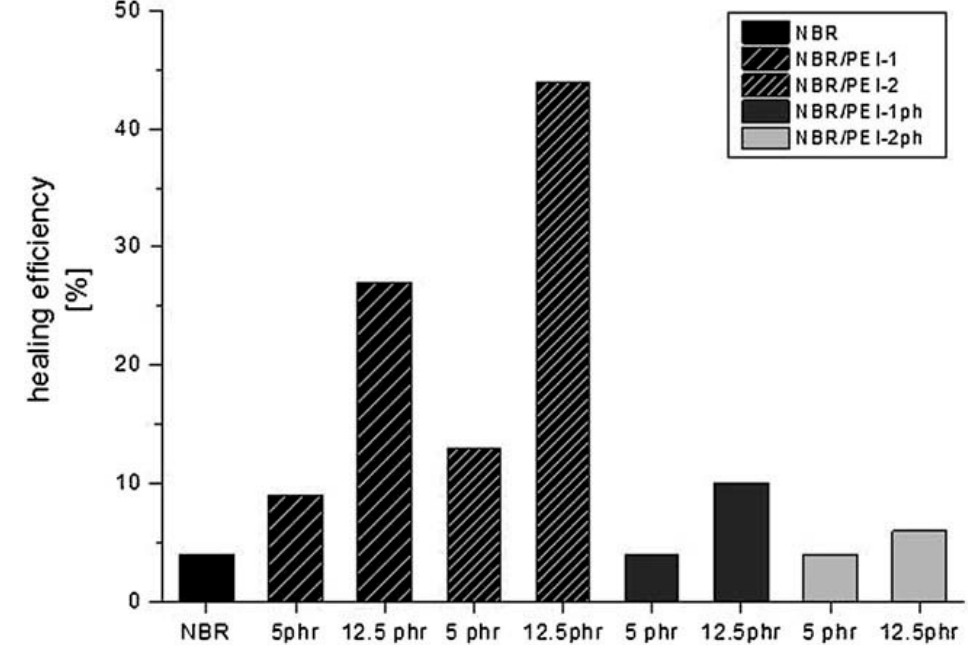
Figure 10. Self-healing efficiency of pure nitrile butadiene rubber (NBR) strips and strips made of various types of microphase separated NBR/polyethyleneimine (PEI) blends after the strips were cut in half, re-joined under compression and subsequently annealed for 12 h at 100 ◦ C and stored for 12 h at room temperature. Best self-healing efficiency was obtained with NBR/PEI-2 blends with a high PEI content (12.5 phr) of unmodified PEI with high molecular mass (2000 g mol − 1 ). Reprinted from [76] by permission of John Wiley & Sons, Inc.